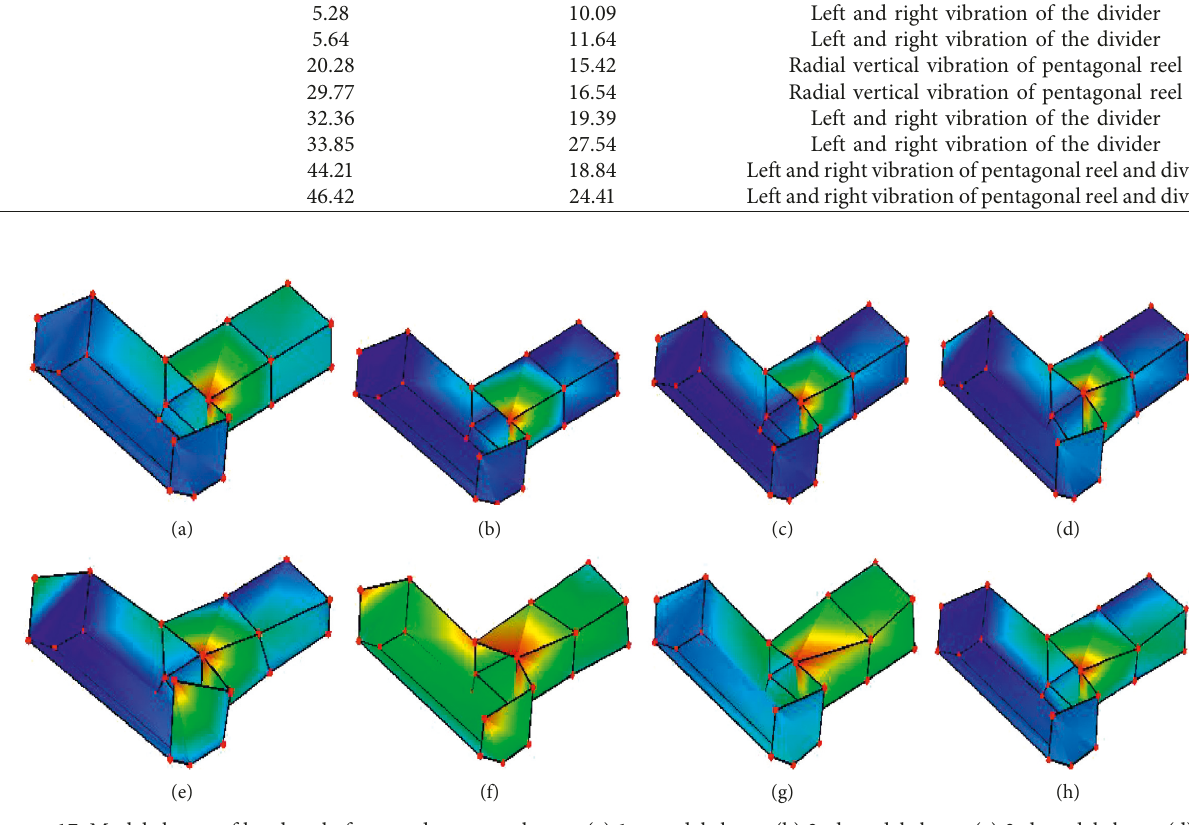
Figure 17: Modal shapes of header platform and conveyer house. (a) 1st modal shape. (b) 2nd modal shape. (c) 3rd modal shape. (d) 4th modal shape. (e) 5th modal shape. (f) 6th modal shape. (g) 7th modal shape. (h) 8th modal